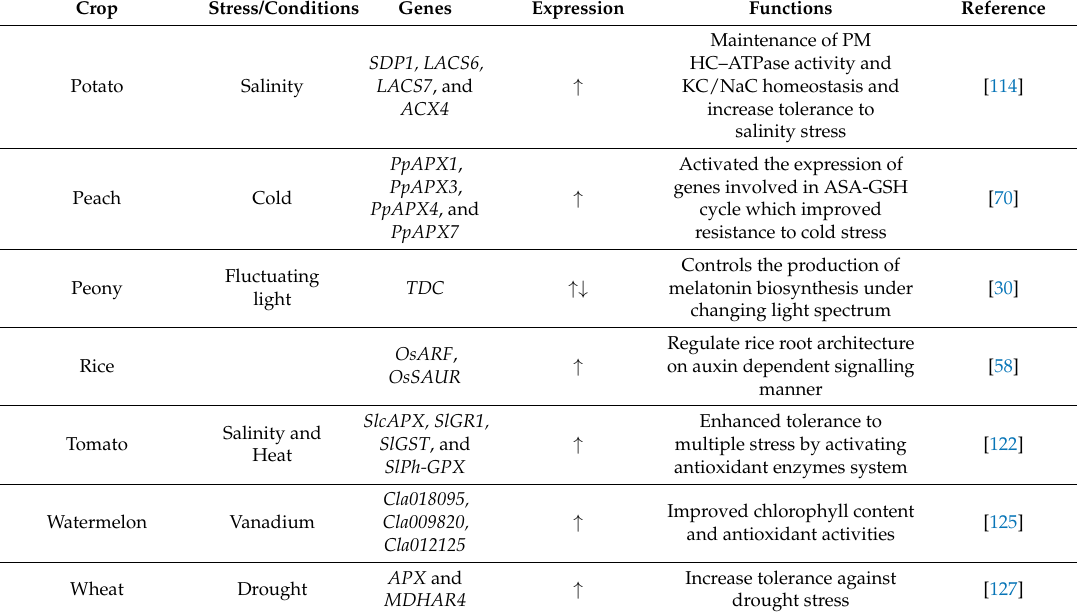
↑ showing up-regulation and ↓ down-regulation of the respective genes presented in the